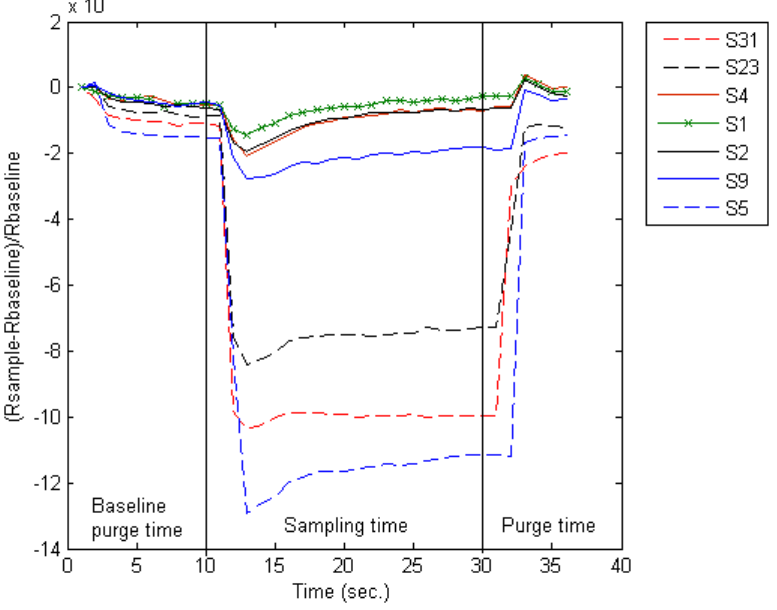
Figure 3. Measurements taken from seven of the sensors for one sampling